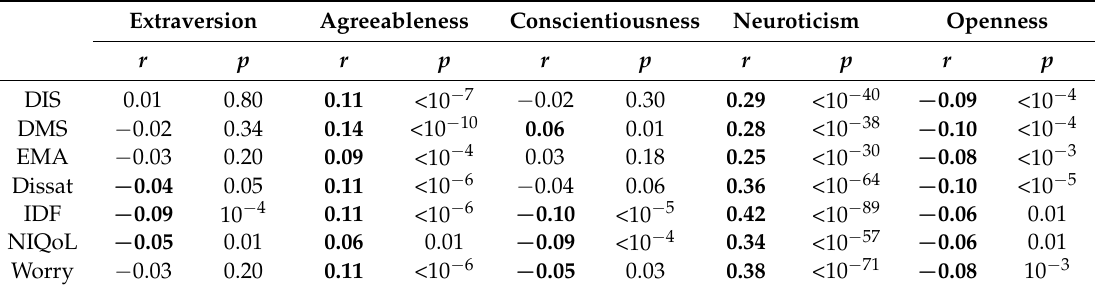
Table 3. Polychoric correlation coefficients and corresponding p -values for the correlations between each of the five personality traits and each of the individual Insomnia Severity Index